Question: What does this figure show? Answer in one sentence.
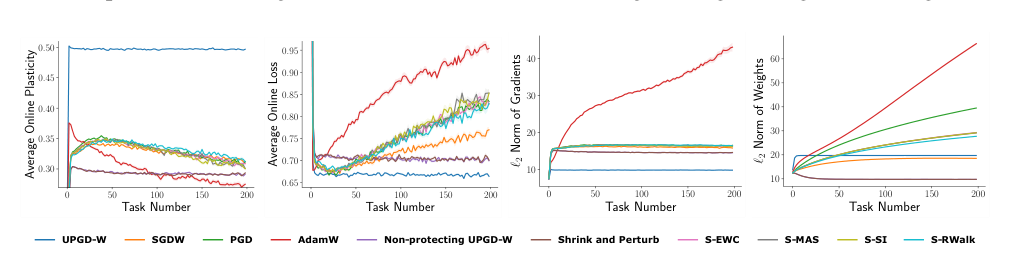
Answer: Additional diagnostic statistics of methods on Input-permuted MNIST. The average plas- ticity, the average online loss, the ℓ1-norm of gradients, and the ℓ2-norm of weights are shown.